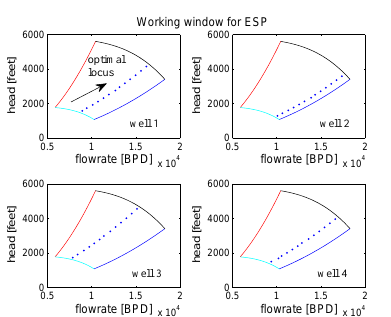
Figure 4: Optimal locus of the pump head inside its operating window for different separator ca- pacities for case I